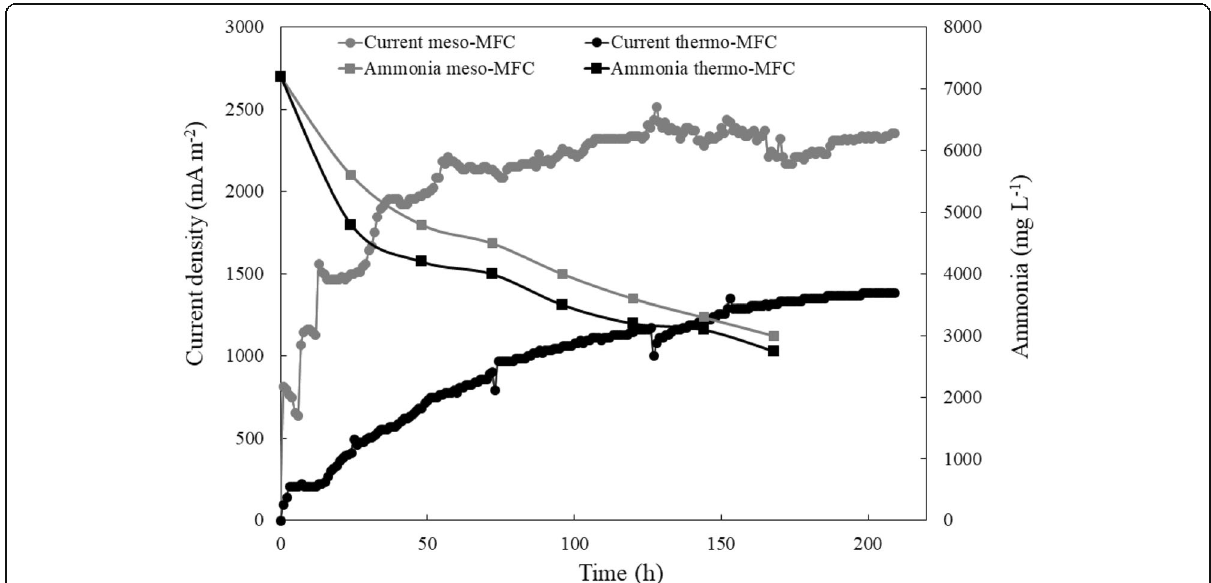
Fig. 6 Current density and ammonia concentration of the thermo- and meso-MFC with high strength of organic and ammonia in leachate B. The ammonia toxicity is alleviated as ammonia concentration gradually decreased, and as a result, the current generation is restored and